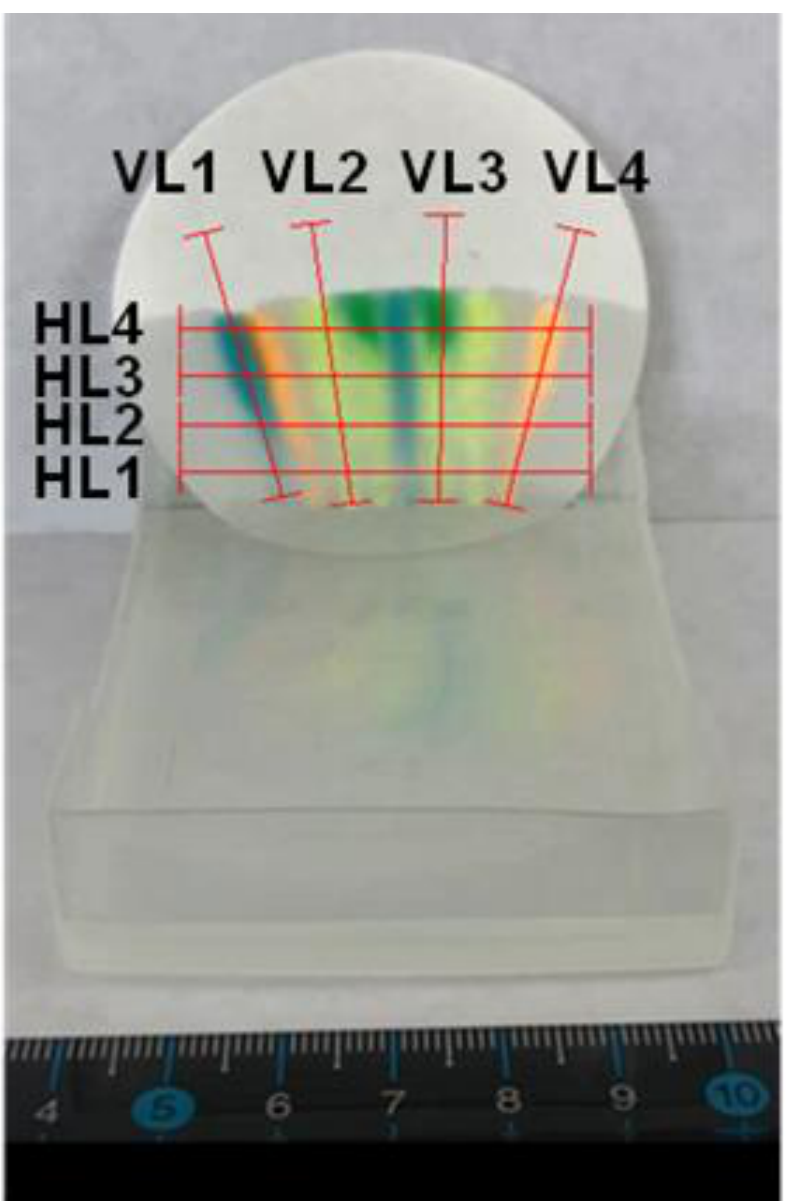
Figure 5. Time cross-section operation of four vertically sloped line segments (VL1~VL4) and four horizontal line segments (HL1~HL4) from entire frames of images for information extraction using PicMan.